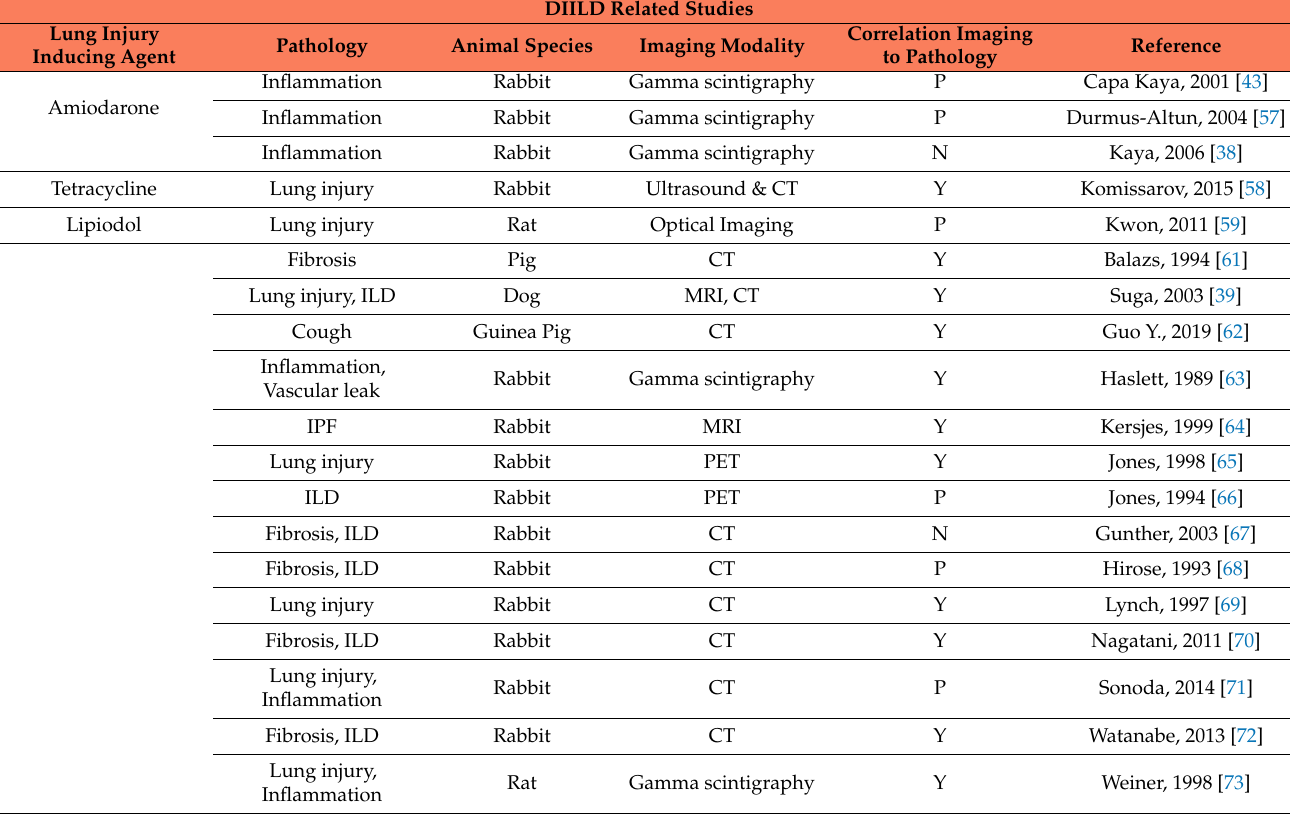
Table 9. The most drug-induced interstitial lung disease (DIILD)-related studies and the pathologies that were studied. DIILD Related Studies Lung Injury Correlation Imaging Pathology Animal Species Imaging Modality Inducing Agent to Pathology